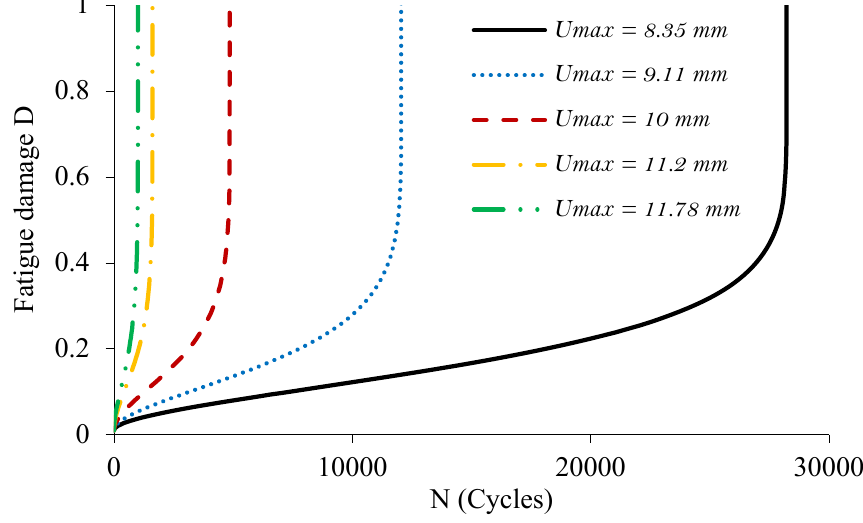
Figure 16. Simulated damage evolution at the extreme fixed outer layer of PA66GF30 specimens.